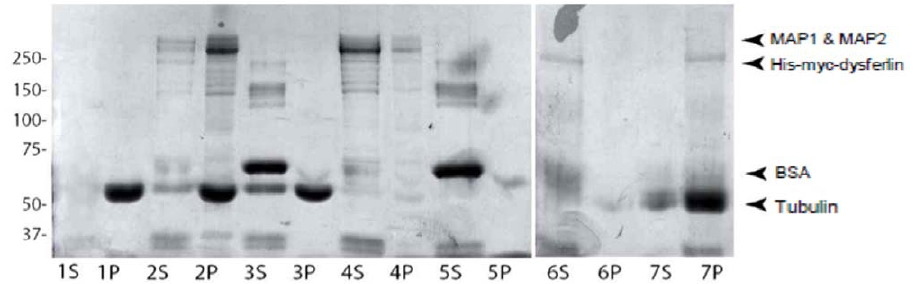
Figure 6. Dysferlin binds to microtubules. His-myc-dysferlin purified on Ni-NTA beads was incubated with polymerized microtubules. Reactions were resolved by SDS-PAGE stained with SimplyBlue SafeStain. Arrows point to His-myc-dysferlin, tubulin, BSA, and to MAP1&MAP2 of the microtubule-associated protein fraction (MAPF), which includes MAP2A, MAP2B, MAP1 and tau. S: Soluble phase, P: Pellet. Lane 1: Microtubules alone, lane 2: Microtubules incubated with MAPF, lane 3: Microtubules incubated with BSA, lane 4: MAPF alone, lane 5: BSA alone, lane 6: Purified His-myc- dysferlin alone, lane 7: Microtubules incubated with purified His-myc-dysferlin.